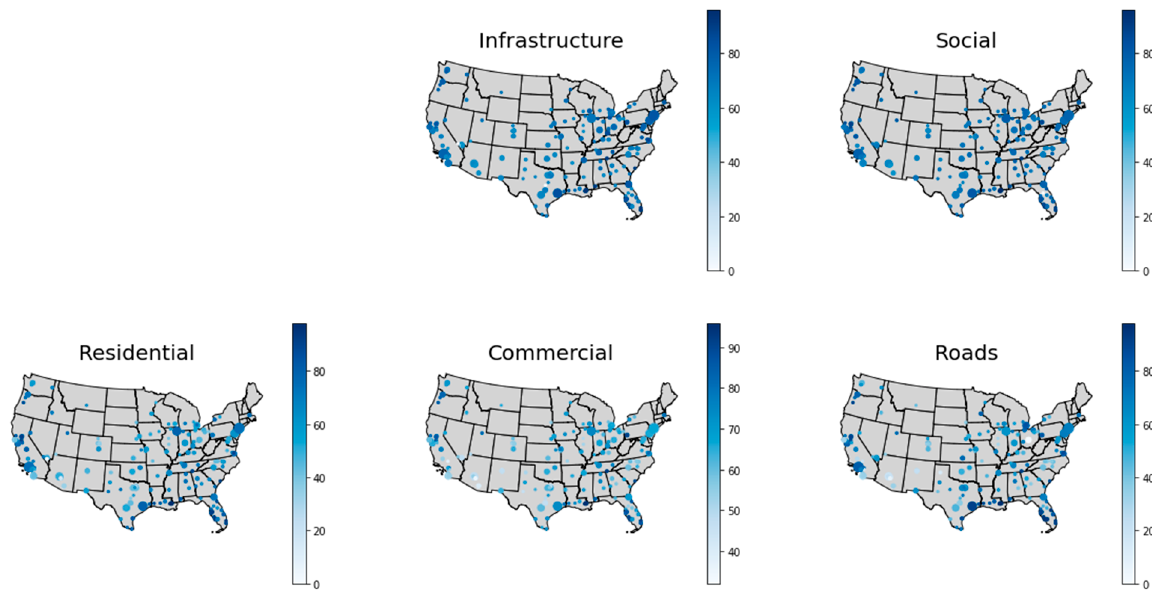
Figure 5. City comparison for each dimension (Percent of infrastructure with operational risk).